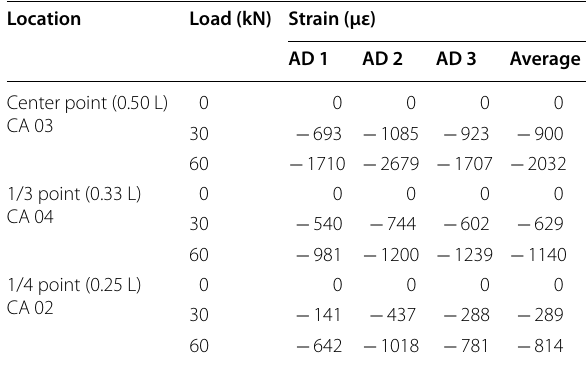
Table 6 Test results of load–concrete strain data